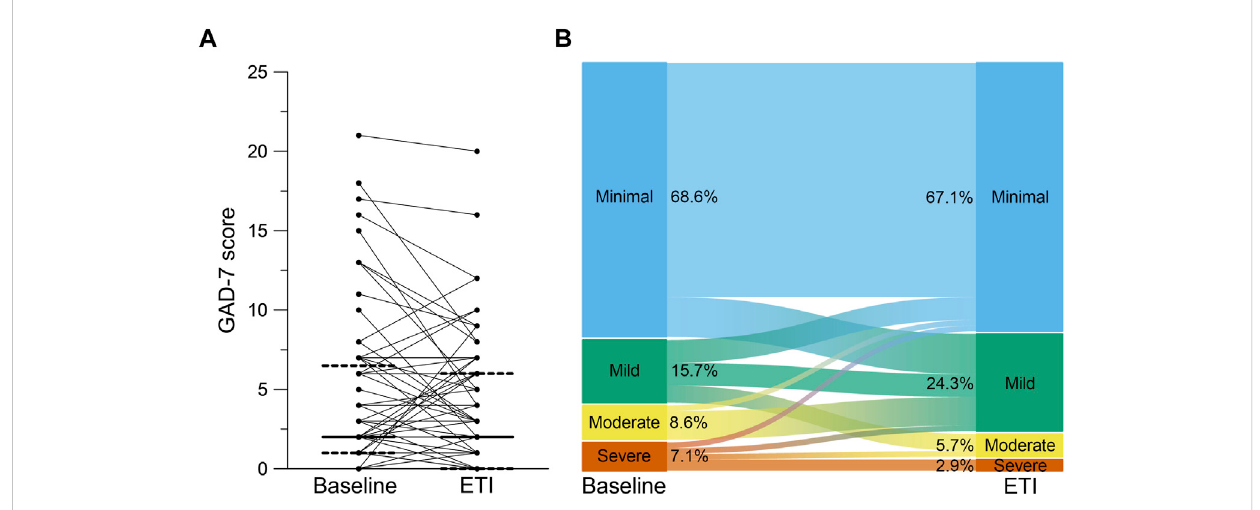
FIGURE 4 Effectsofelexacaftor/tezacaftor/ivacaftor(ETI)onsymptomsofanxiety. (A) PairedassessmentofGeneralizedAnxietyDisorderScale-7Items(GAD- 7) in patients with CF and at least one F508del mutation at baseline and after initiation of ETI therapy. (B) Alluvial graphic depicting the proportions of the categories minimal (blue), mild (green), moderate (yellow) and severe (red) symptoms of anxiety assessed by GAD-7 in CF patients at baseline and after initiation of ETI therapy. Solid lines represent the group median and dashed lines represent 25th and 75th